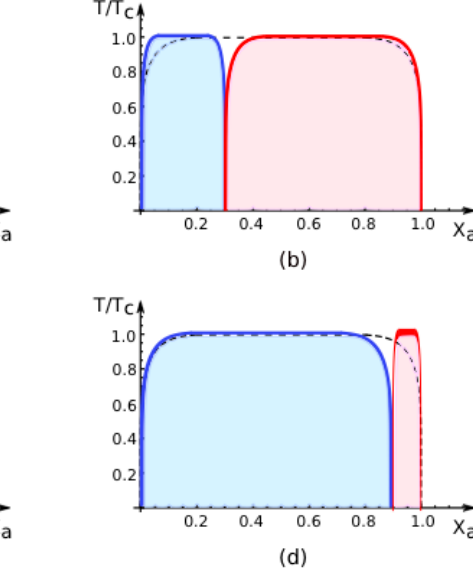
Figure 5. Exact phase diagrams of the lattice model for adhering membranes as a function of mole fraction X a and reduced temperature T/T c for different area fractions q [1] = 0 . 1 , 0 . 3 , 0 . 5 , and 0 . 9 in ( a ), ( b ), ( c ), and ( d ), respectively. The affinity contrast ∆ U 2 , 1 is kept fixed at a large positive